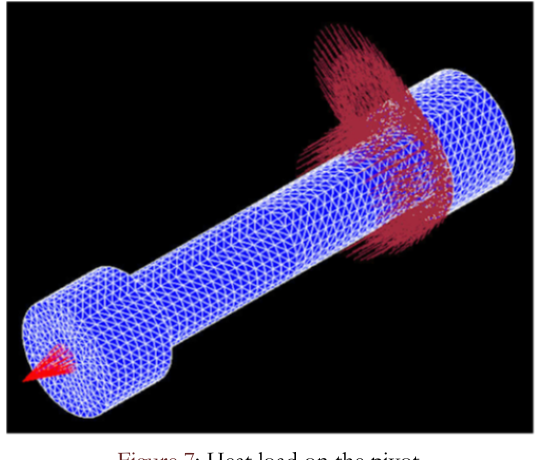
Figure 7: Heat load on the pivot.